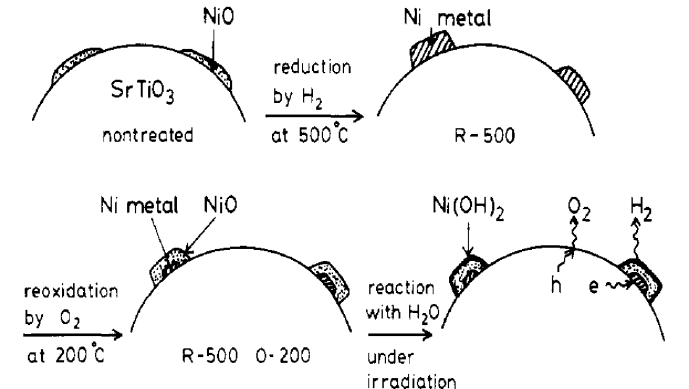
photocatalyst after reduction and oxidation treatments reprinted Figure 3. NiO-SrTiO 3 (adapted) with permission from ref [49]. Copyright (1986) American Chemical